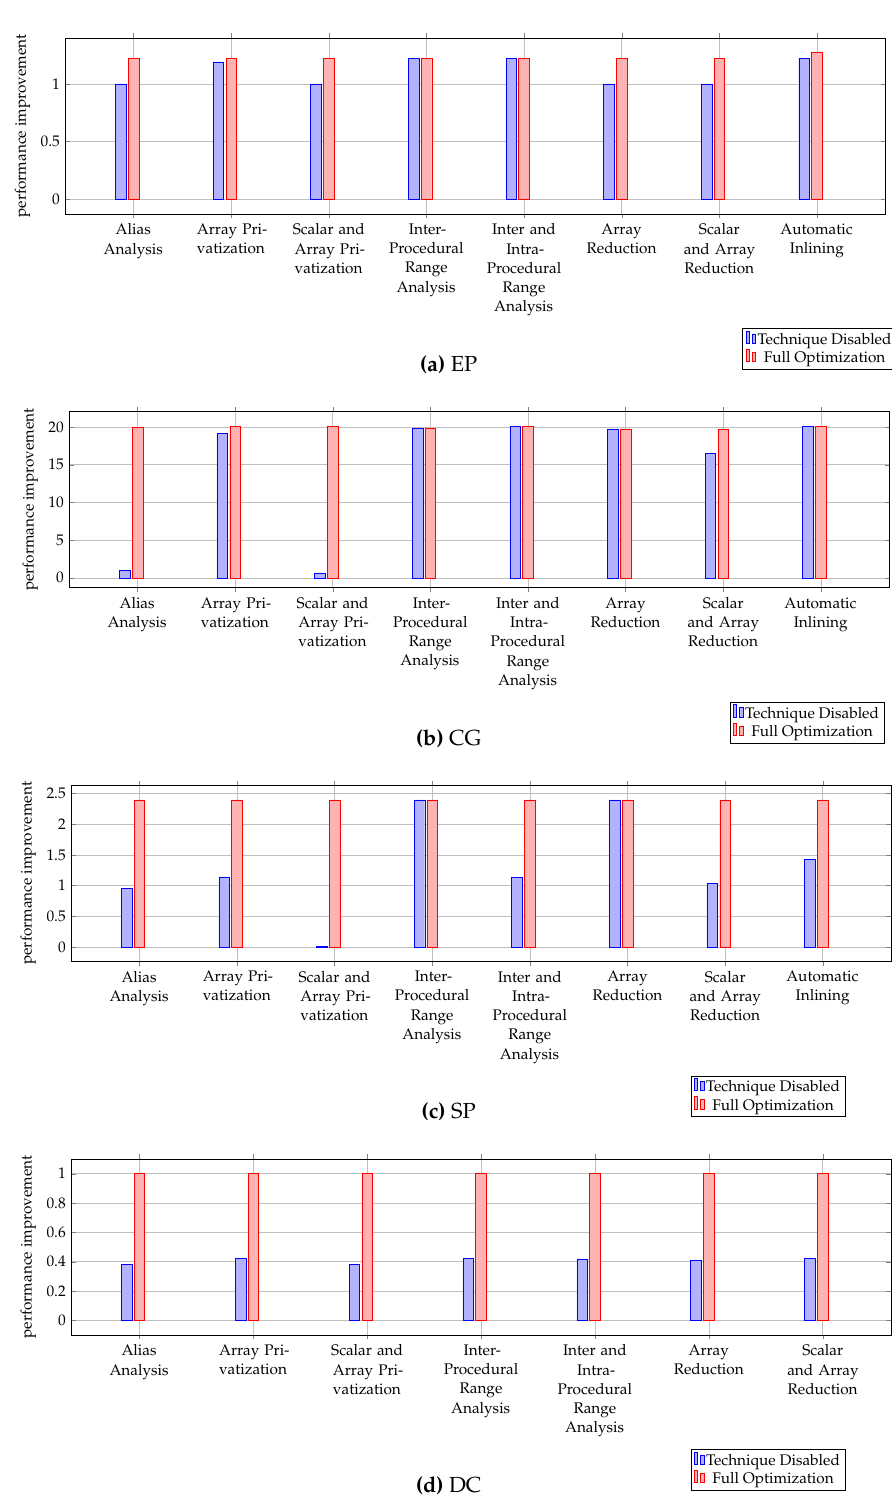
Figure 4. ( a ) Performance results for EP, ( b ) Performance results for CG, ( c ) Performance results for SP and ( d ) Performance results for DC benchmarks from the NAS Parallel benchmark suite v3.3 for input class B. The selected base case is the best tuned version (all on). One technique at a time is turned off, and the impact on performance is plotted (Lower bar means a higher impact of the